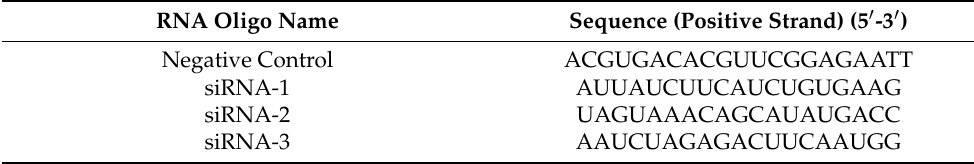
Table 1. Sequences of sense strand of siRNA against the target gene in